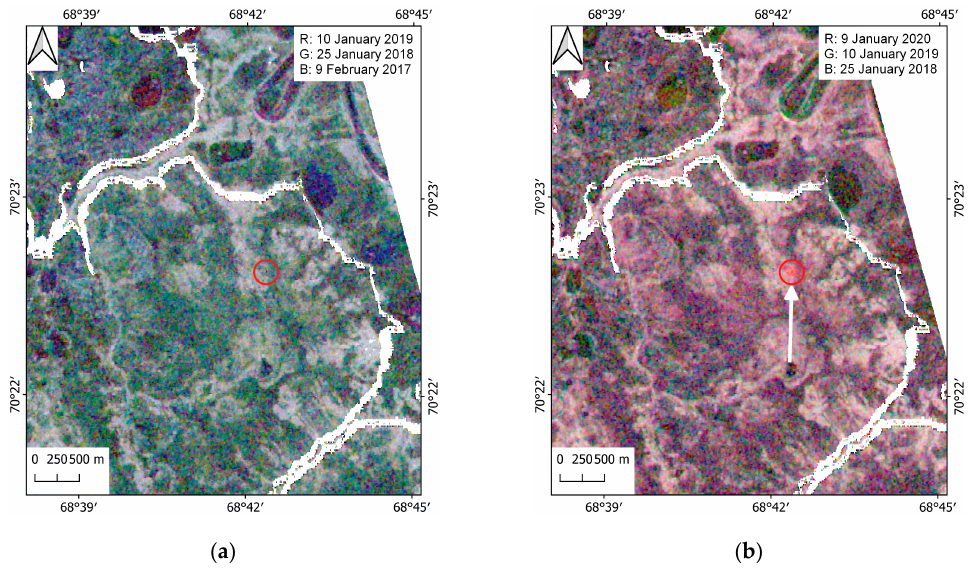
Figure 3. Multi ‐ temporal RGB composites of radar backscattering (dB) at HV polarization: ( a ) red for 10 January 2019, green for 25 January 2018, blue for 9 February 2017; ( b ) red for 9 January 2020, green for 10 January 2019, blue for 25 January 2018. Red circle marks the heaving area with a buffer